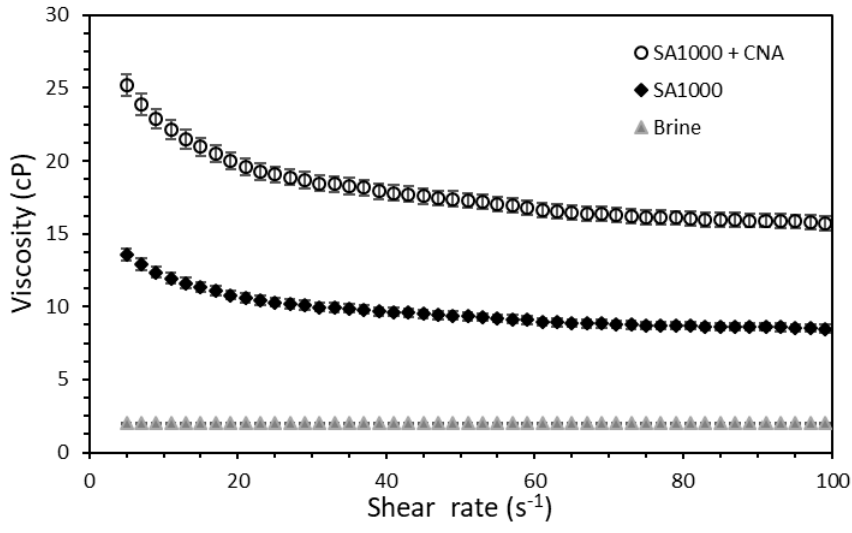
Figure 12. Rheological behavior (viscosity vs. shear rate) for brine and the dispersions in the absence and presence of the evaluated nanoparticles at a fixed concentration of 100 mg·L − 1 measured at 50 °C.